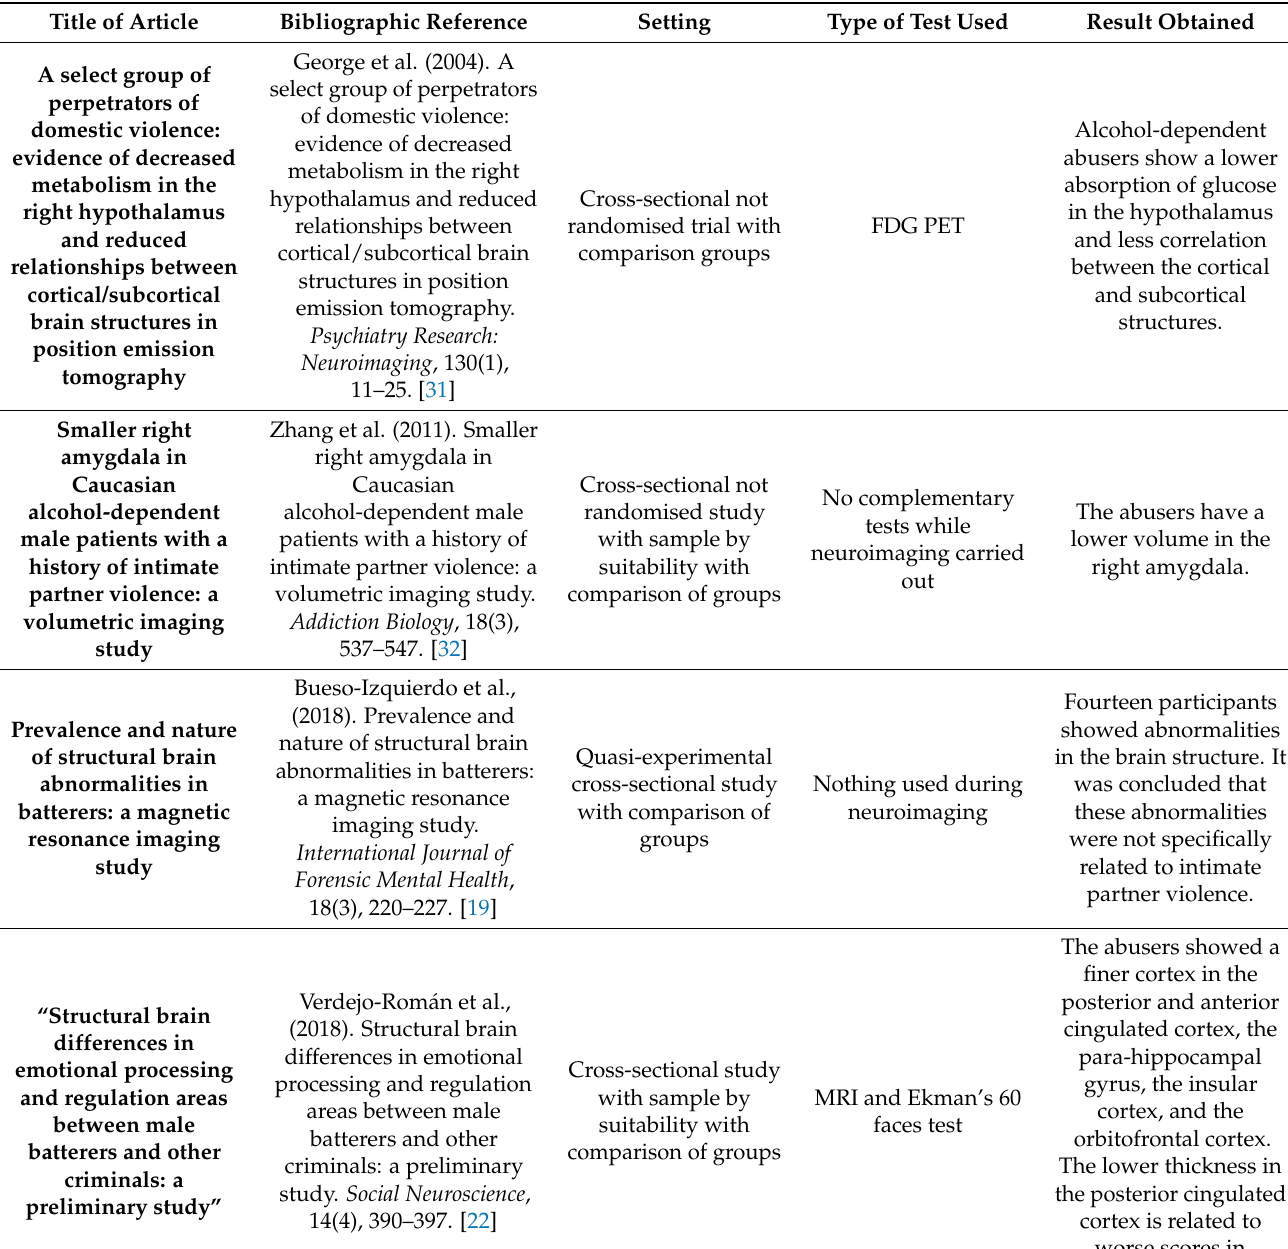
Table 2. Articles, authors, complementary tests (or not), and results obtained from the neuroimaging in studies using neuroimaging